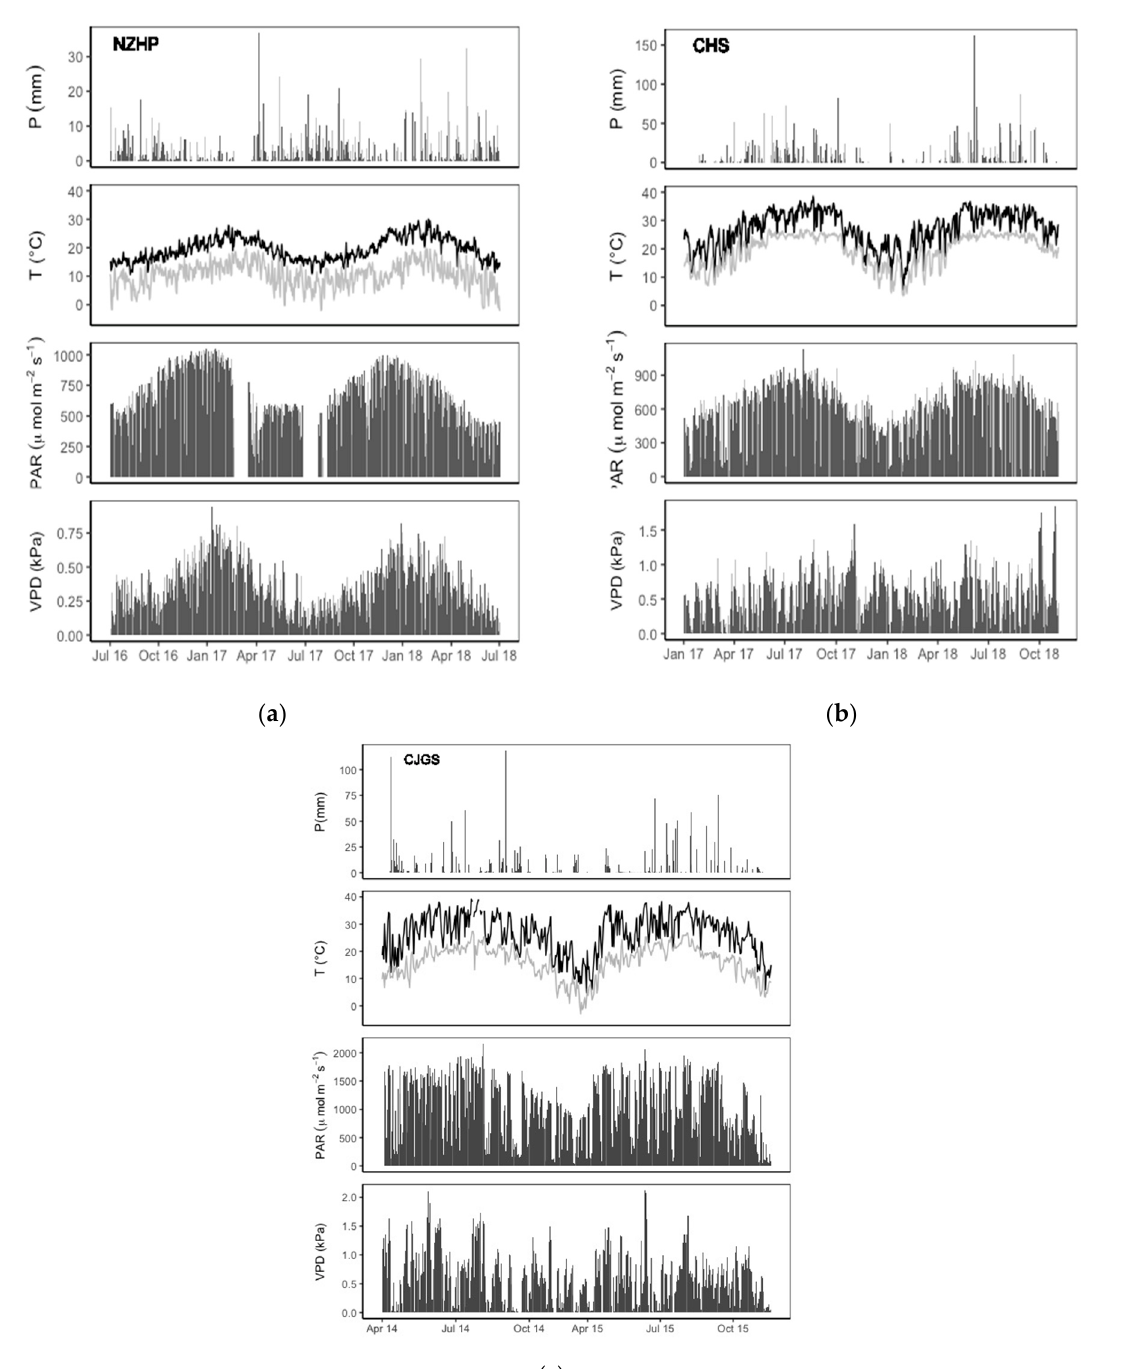
Figure 1. Environmental conditions for three climatic zones among NZHP ( a ), CHS ( b ) and CJGS ( c ) over two years. Values are: total daily precipitation (mm); minimum (grey line) and maximum (black line) temperature (T °C); daily maximum PAR (µmol m − 2 s − 1 ); daily average VPD (kPa).